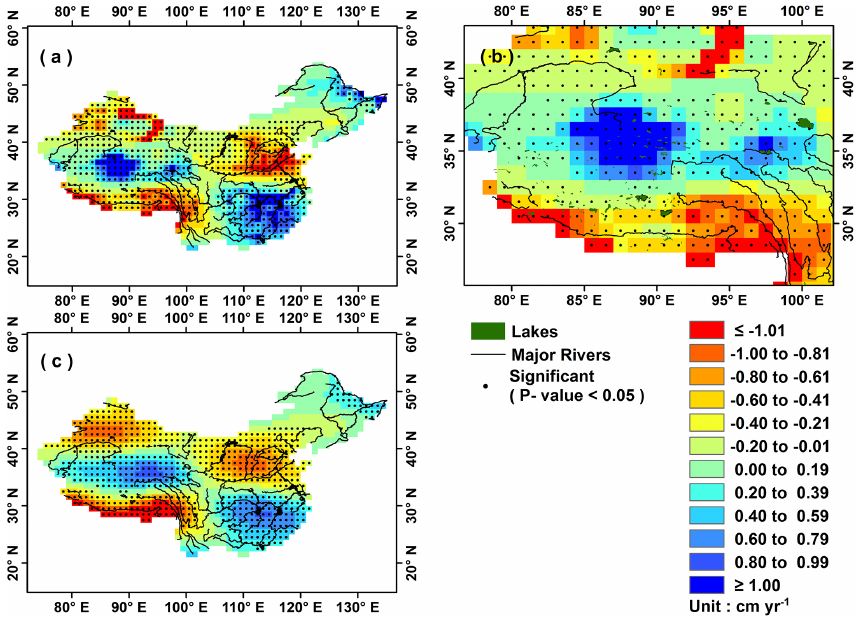
Figure 7. Spatial distribution of trends derived from linear least squares regression for TWS in 2003–2013 (unit: cmyr − 1 ); (a) and (b) are linear trends from the scaled GRACE data and a detailed diagram of the data for west part of China, (c) is the linear trend from the unscaled GRACE data. Grids with trends significant ( F test) at 95% confidence level are marked with black dots.